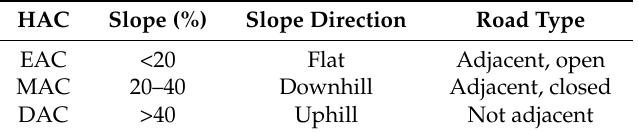
Table 2. Accessibility class characteristics in the study